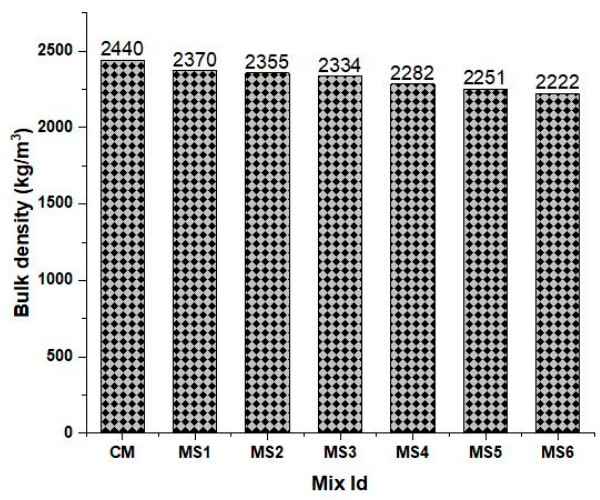
Figure 3. Bulk density of various concrete mixes.